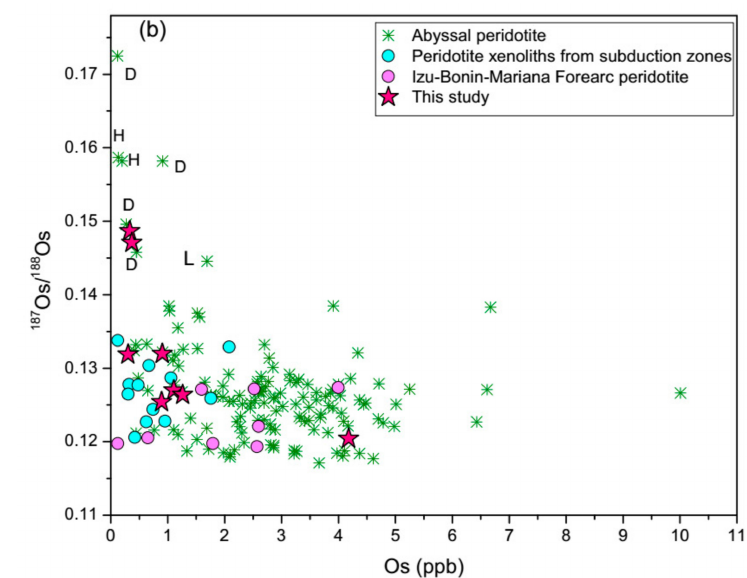
Figure 4. Plots of 187 Os / 188 Os versus the ( a ) Re and ( b ) Os content of the Yap Trench peridotites. D, H, and L represent dunite, harzburgite, and lherzolite, respectively. The abyssal peridotites [7,9–12,44], the peridotite xenoliths from subduction zones [17], and the Izu–Bonin–Mariana forearc peridotites [18] are shown for comparison.